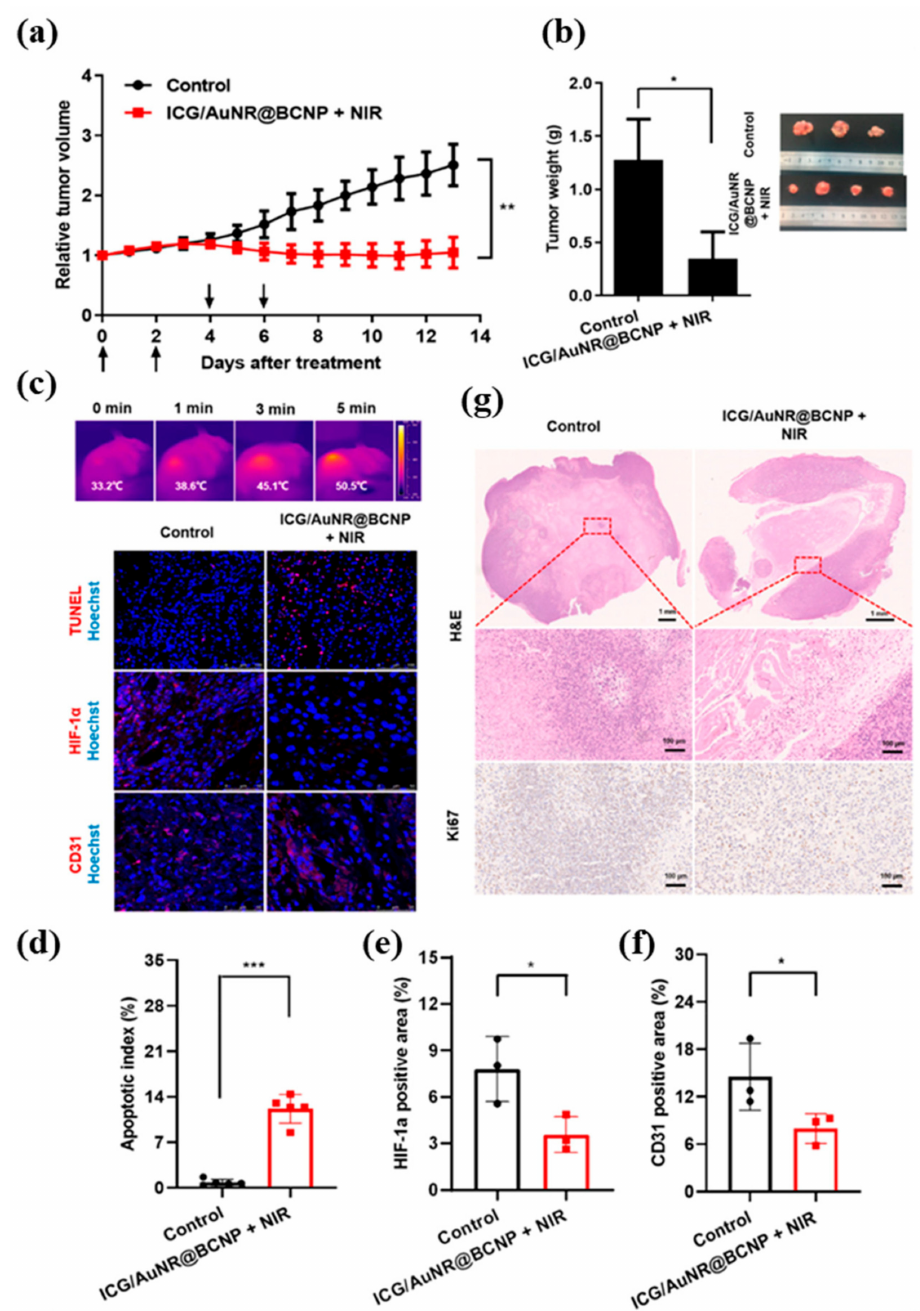
Figure 4. ( a ) Relative tumor growth curves recorded during treatment. The dosage of ICG/AuNR@BCNP in mice was equivalent to ICG 1.0 mg/kg and Au 0.76 mg/kg. ( b ) Weight and photograph of isolated tumor at the end of treatment. ( c ) Immunofluorescence staining of tumor sections with TUNEL, anti-HIF-1 α , and anti-CD31 antibody. Scale bar: 50 or 100 µ m. Corresponding semiquantitative analysis of ( d ) the apoptotic index and ( e ) HIF-1 α and ( f ) CD31 positive areas (mean ± SD, n = 3–5, * p < 0.05, ** p < 0.01, *** p < 0.001). ( g ) H&E and ki67 staining of tumor sec- tions. Scale bars: 1 mm for low magnification, 100 µ m for high magnification. Reproduced with permission [95]. Copyright 2020, American Chemical